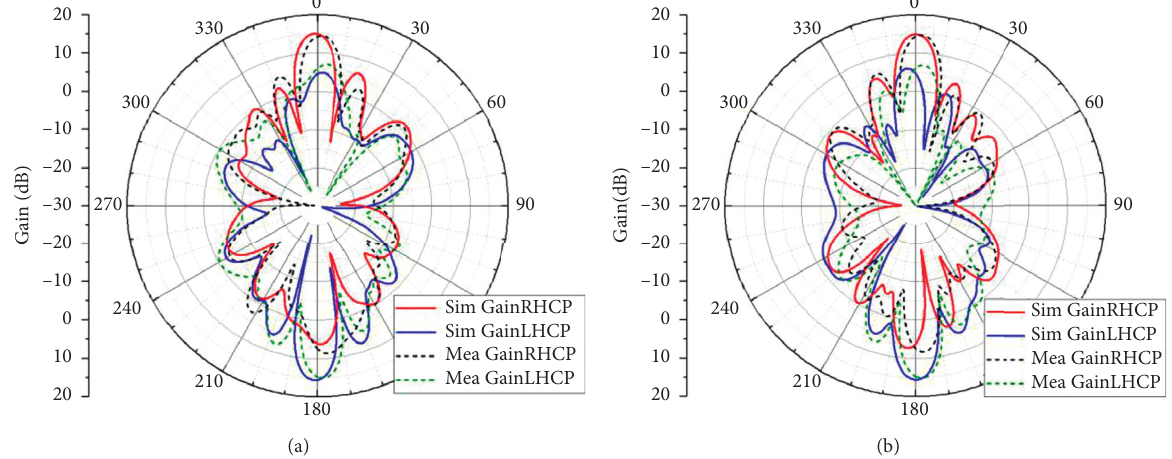
Figure 16: Simulated and measured results of antenna pattern. (a) E-plane. (b) H-plane.